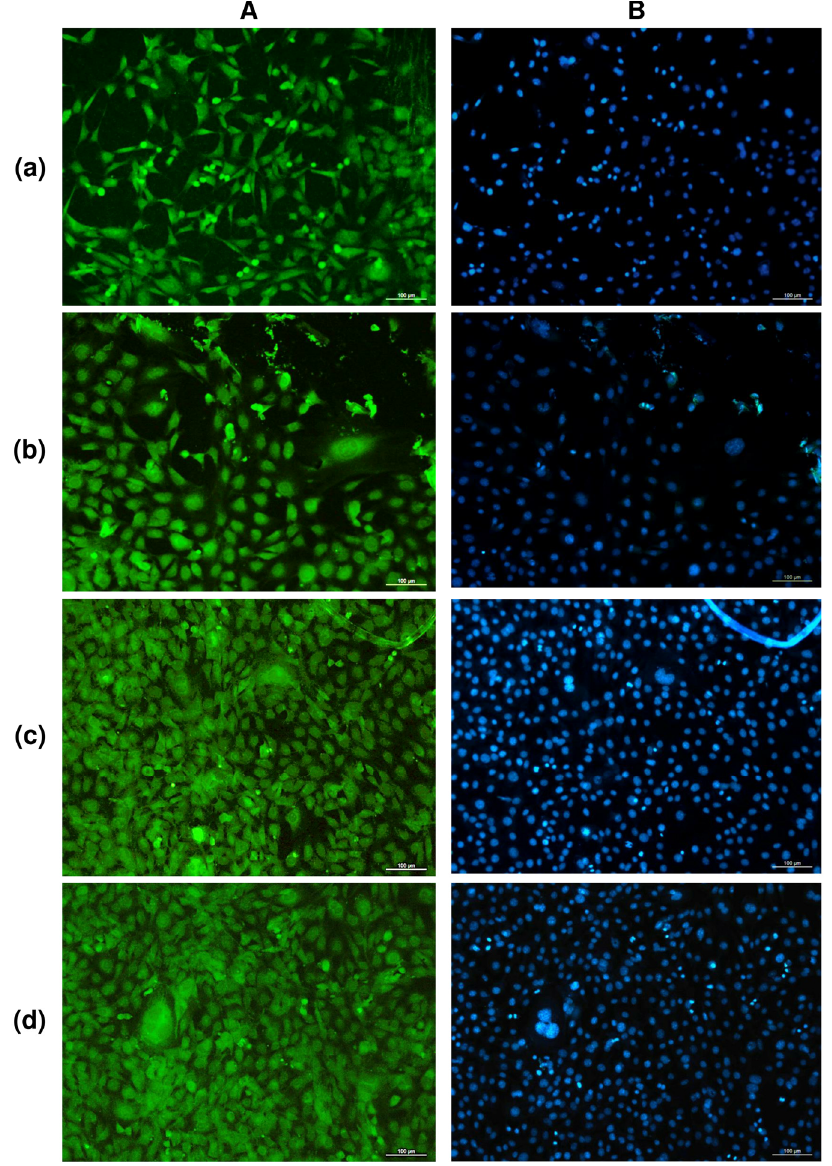
Figure 3. FITC ( A ) and DAPI ( B ) staining of fibroblasts NIH 3T3 on PHA films of various composi- tions: ( a )—P(3HB); ( b )—P(3HB-co-32.2 mol.% 3HV; ( c )—P(3HB-co-35.5 mol.% 4HB; ( d )—P(3HB-co- 38.0 mol.% 3HHx; (2-day culture) bar 100 µ